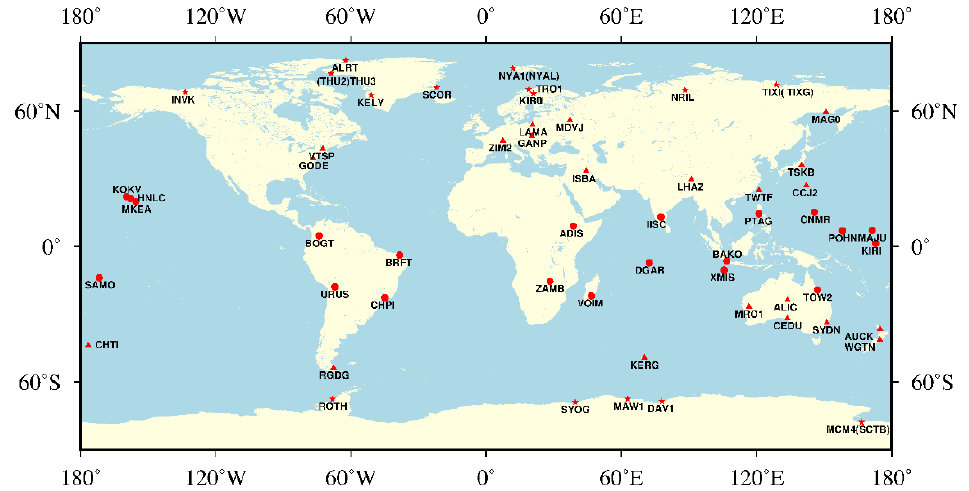
Figure 6. The location information of GNSS stations to analyze the seasonal variations of RMSE with respect to reanalysis products (source: own elaboration).